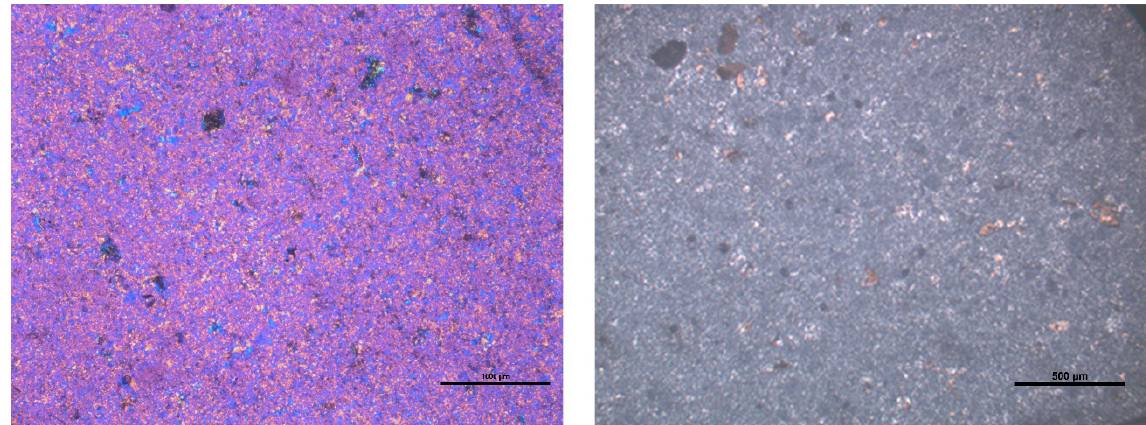
Figure 11. View of the petrographic analysis of the translucent flint. (Crossed polarisers.) The left scale bar is 1000 μm, the right is 500 μm.